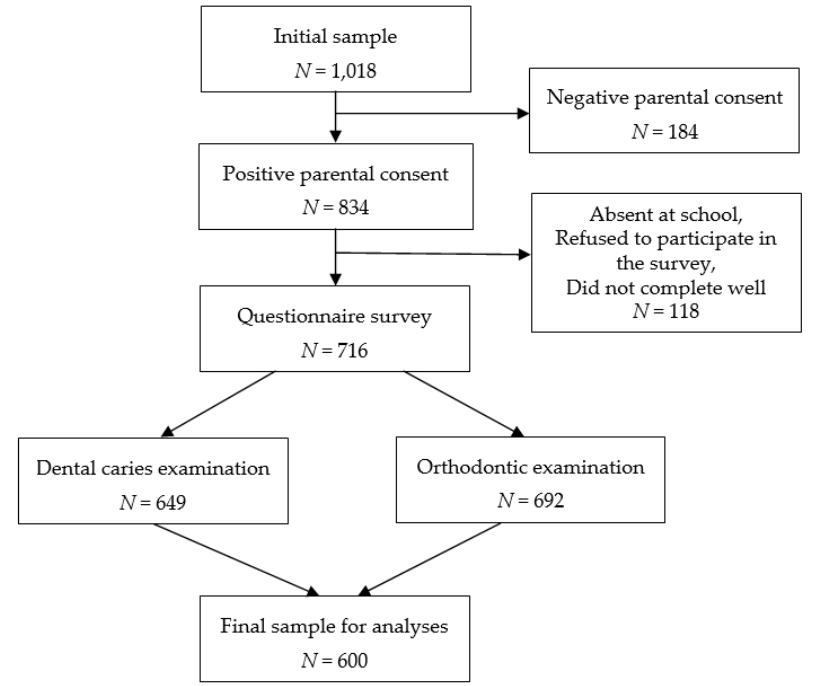
Figure 1. Flow chart of the participant examination process.